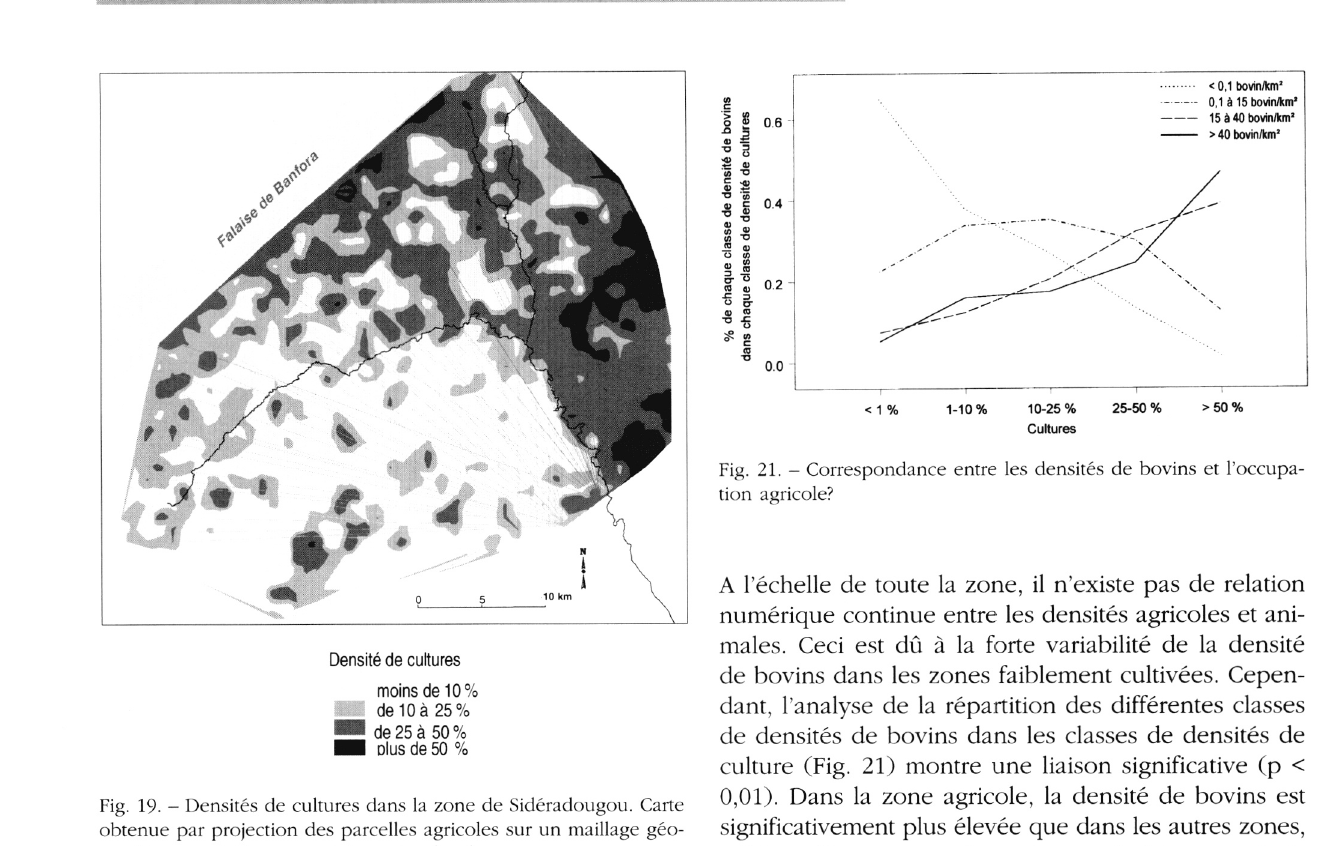
Fig. 19. - Densités de cultures dans la zone de Sidéradougou. Carte obtenue par projection des parcelles agricoles sur un maillage géo­ graphique puis lissage par régression locale.